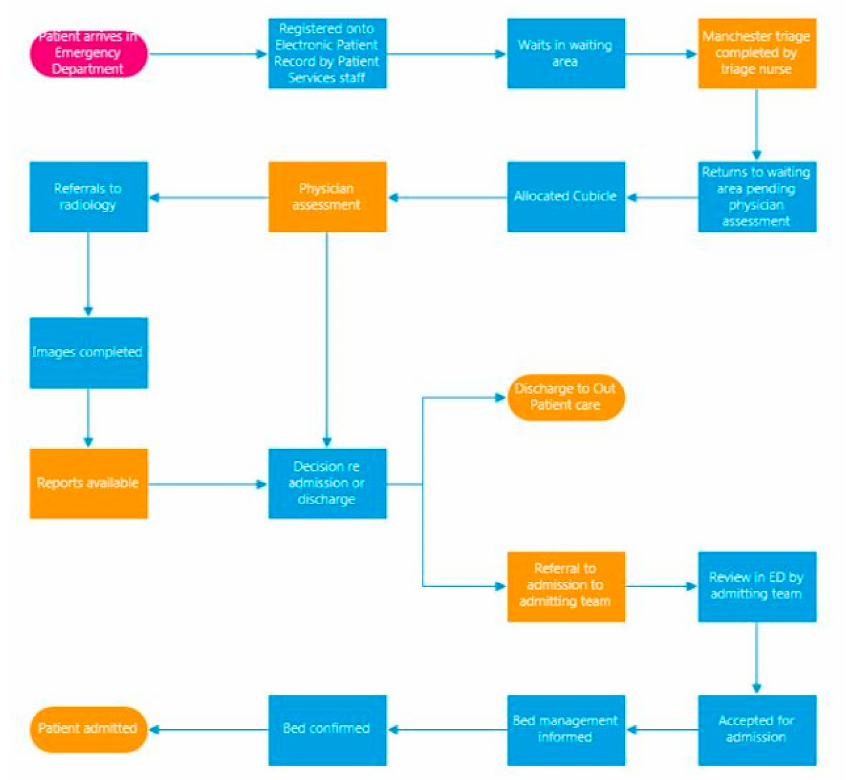
Figure 2. Process map of emergency department patient flow.